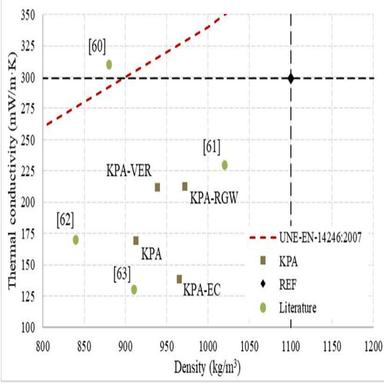
Apparent Density/Thermal conductivity results compared with literature and standard.